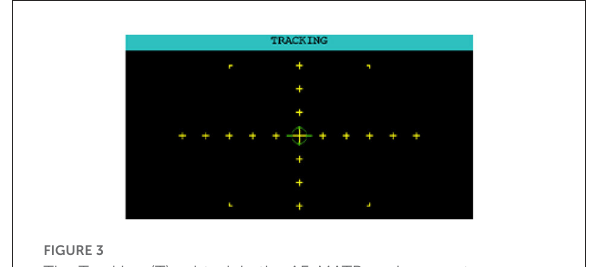
FIGURE3 The Tracking (T) subtask in the AF-MATB environment.